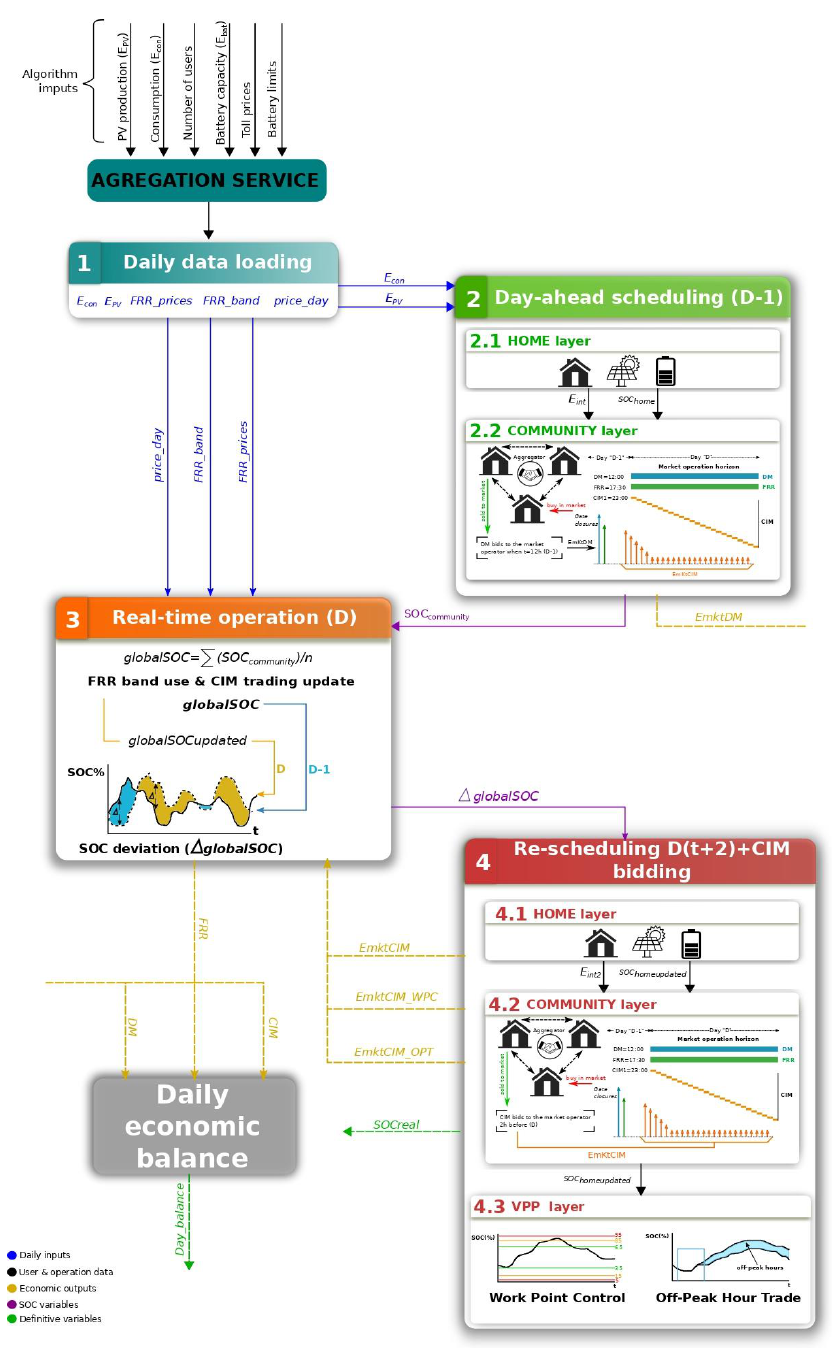
Figure 4. Simplified methodology of the EMS, which comprises MG and VPP